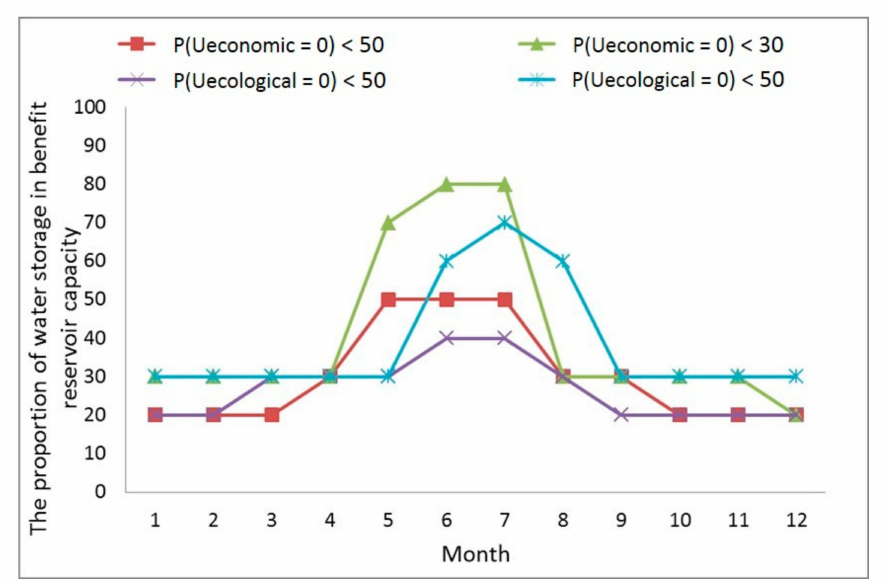
Figure 15. Percentage of storage in beneficial reservoir capacity to be maintained in different periods of time to meet the different requirements of